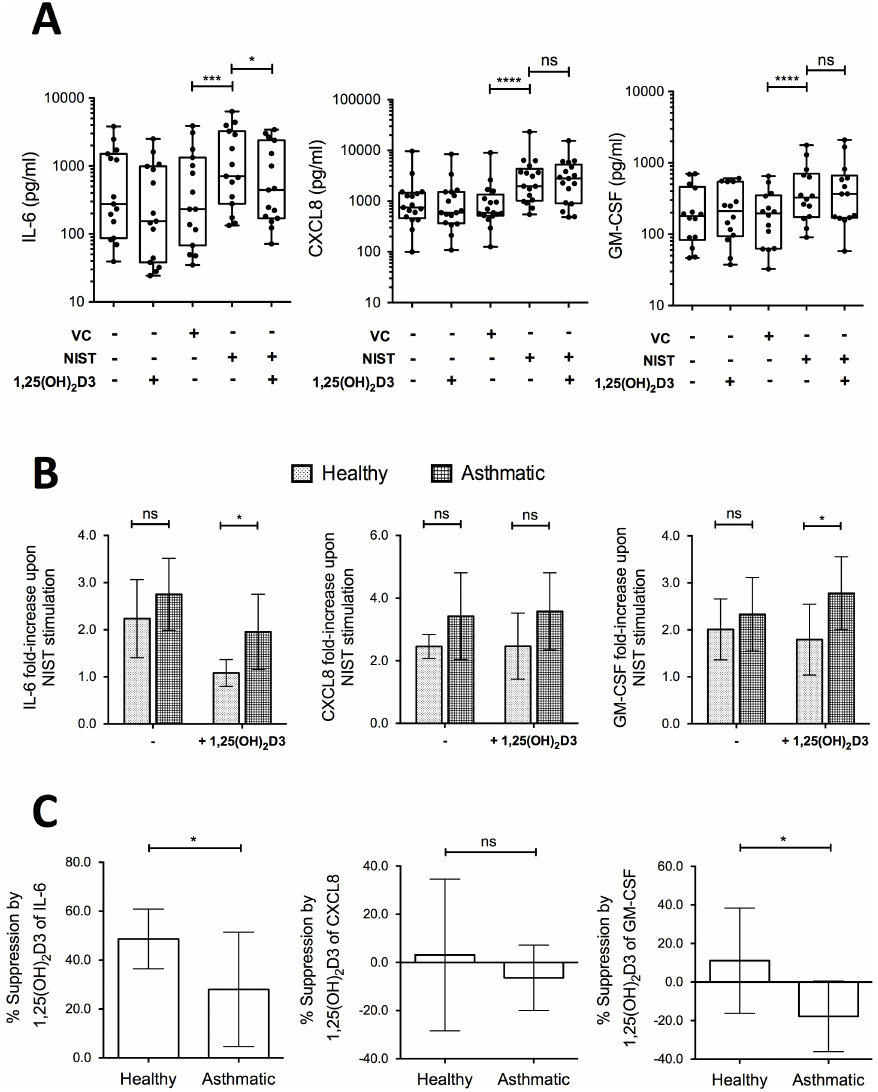
Fig 3. Effects of 1,25(OH) 2 D3 on production of IL-6, CXCL8 and GM-CSF by NIST stimulated HBEC cultures. (A) Addition of 100nM 1,25(OH) 2 D3 reduced production of IL-6 by primary HBEC cultures stimulated for 24 hours with 50μg/ml NIST, but not CXCL8 or GM-CSF. VC: NIST vehicle control. n = 14–17. (B) Fold-increase in production of IL-6, CXCL8, and GM-CSF above that in unstimulated cultures upon stimulation with 50μg/ml NIST in the presence/absence of 1,25(OH) 2 D3, by disease status. Two-way ANOVAs with Bonferroni-corrected post-tests. n = 8–9 healthy, n = 7–8 asthmatic. (C) Percentage suppression by 1,25(OH) 2 D3 of cytokine production in PM-stimulated cultures of HBECs from healthy donors compared to asthmatic donors. Un-paired t-tests. n = 8–9 healthy, n = 7–8 asthmatic. Statistical significance as follows: (cid:3) , p (cid:20) 0.05; (cid:3)(cid:3) , p (cid:20) 0.01; (cid:3)(cid:3)(cid:3) , p (cid:20) 0.001, (cid:3)(cid:3)(cid:3)(cid:3) , p (cid:20) 0.0001.